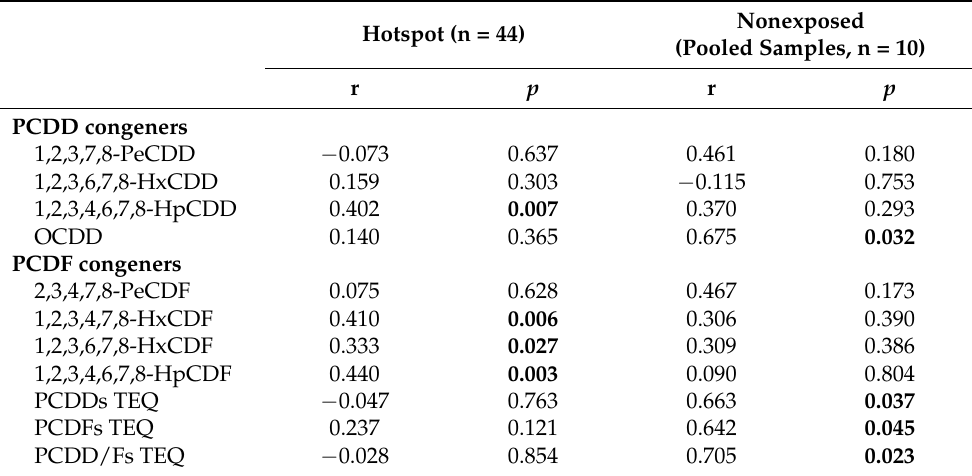
Table 3. Spearman’s rank correlation between the concentrations of PCDD/F congeners in mothers’ breast milk and the children’s serum. Nonexposed Hotspot (n = 44) (Pooled Samples, n = 10) r p r